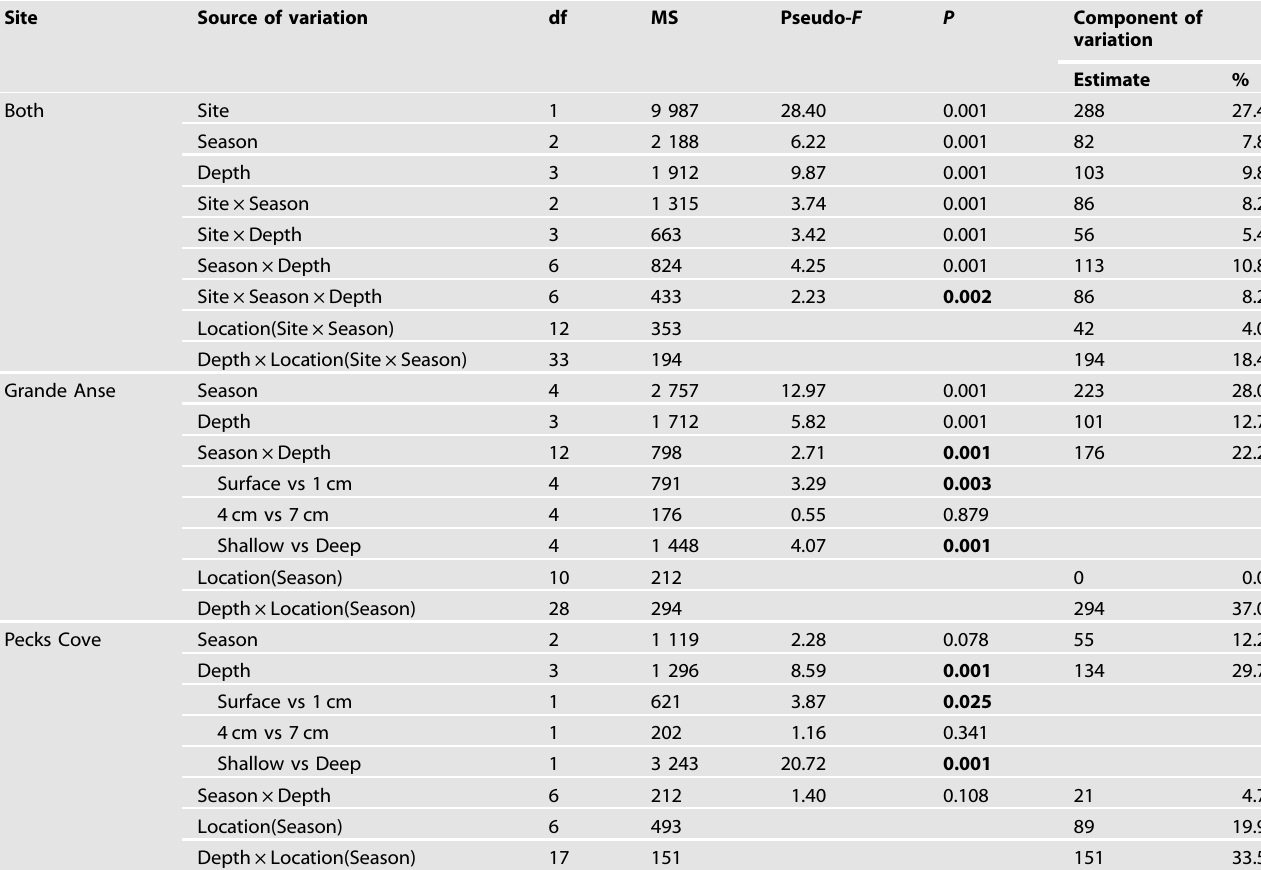
Table 1. PERMANOVA results for spatio-seasonal variations in protist taxa in Bay of Fundy mud fl ats in